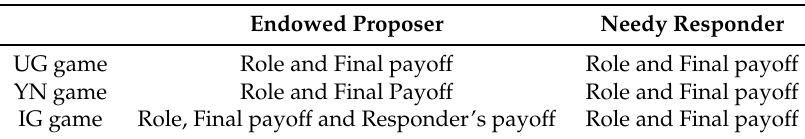
Table 1. Feedback by